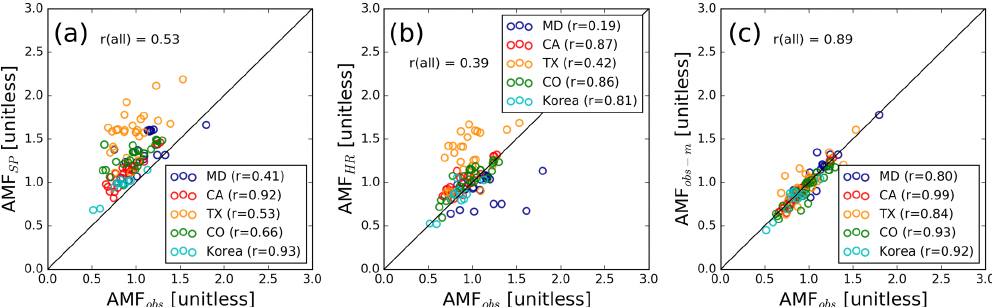
Figure 3. Comparison of AMFs calculated using observed NO 2 profiles (AMF obs ) with tropospheric AMFs in the OMI Standard Product (AMF SP , a ), and those calculated using NO 2 profiles from high-resolution model simulations (AMF HR , b ). Panel (c) compares tropospheric AMFs using daily versus campaign-average profiles (AMF obs-m ). The symbols are color-coded by campaign location.